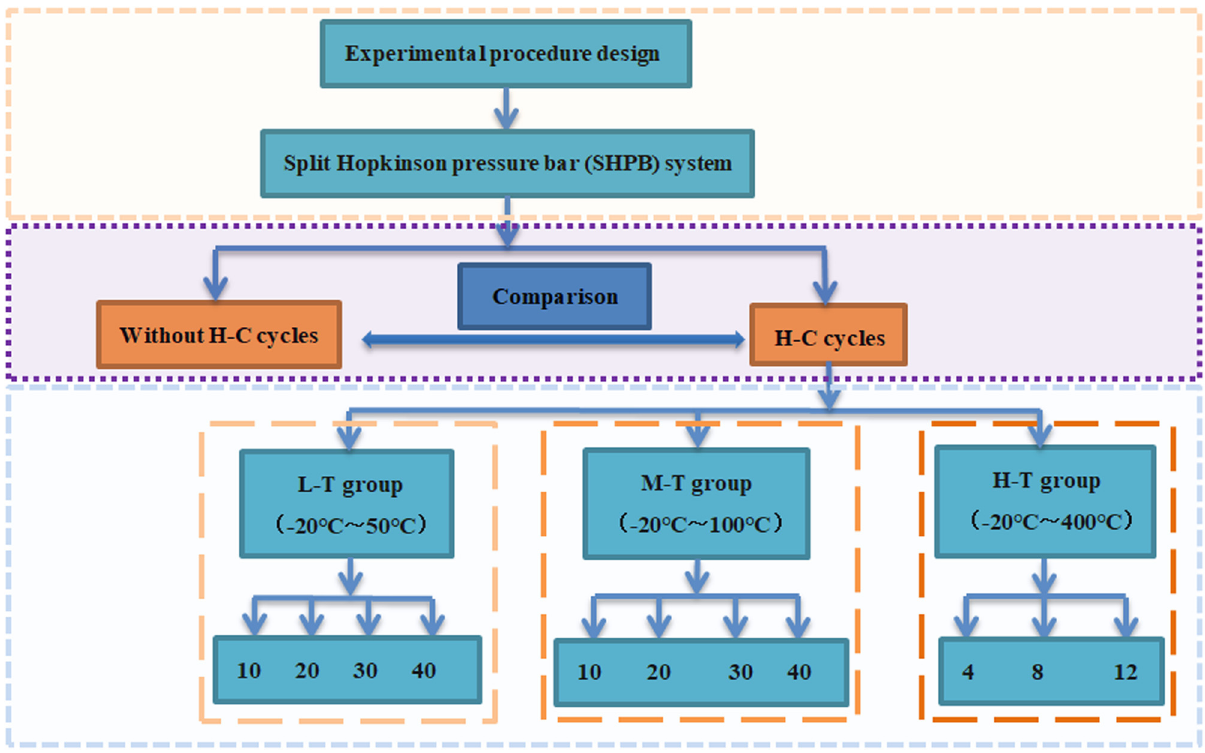
Figure 1: Scheme of the testing